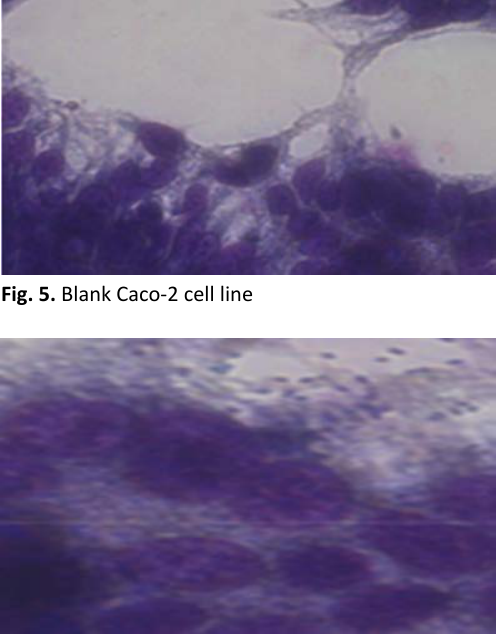
Fig. 8. Lactobacillus sp. (NCIM2056) adhesion study